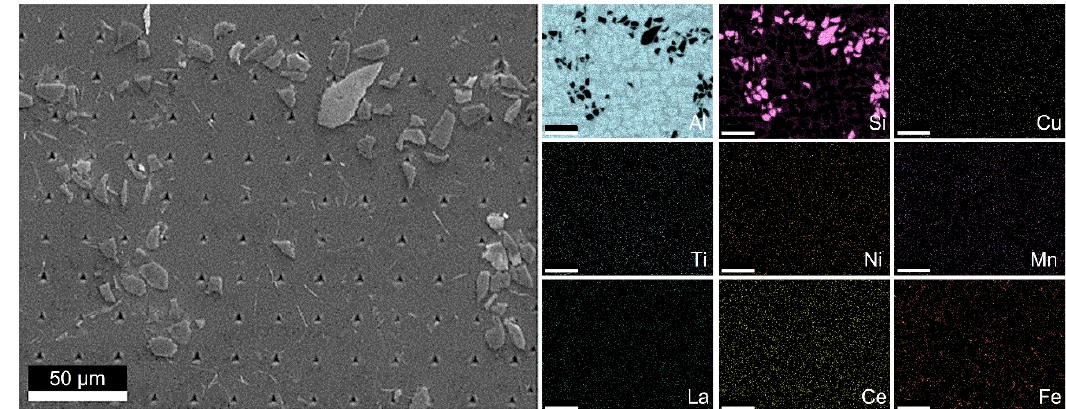
Figure 1. Scanning electron microscopy (SEM) image plus energy-dispersive X-ray spectroscopy (EDS) mapping: Material C0.